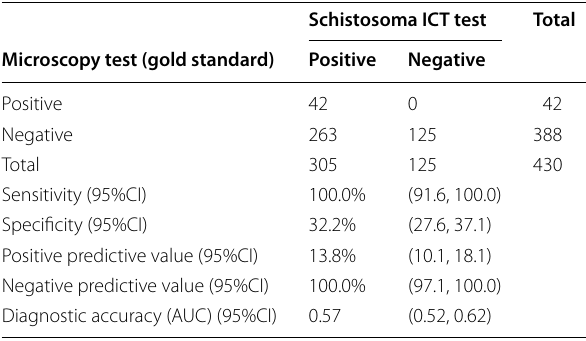
Table 2 Overall sensitivity, specificity, PPV, NPV and diagnostic accuracy of Schistosoma ICT